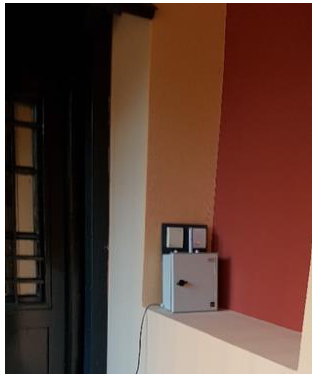
Figure 3. Air quality sensor situated within the building.